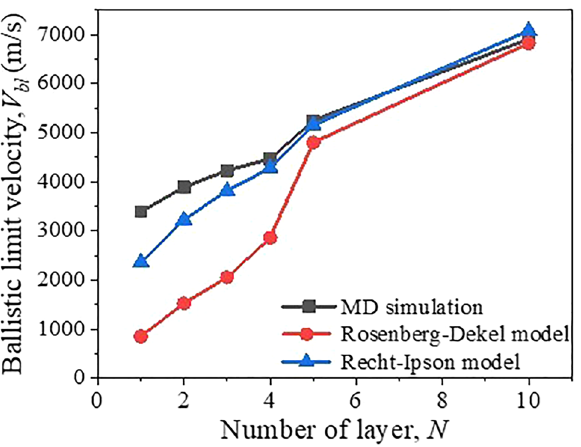
Figure 3. The ballistic limit velocity as a function of the number of layer of graphene obtained from MD simulations and theoretical predictions.